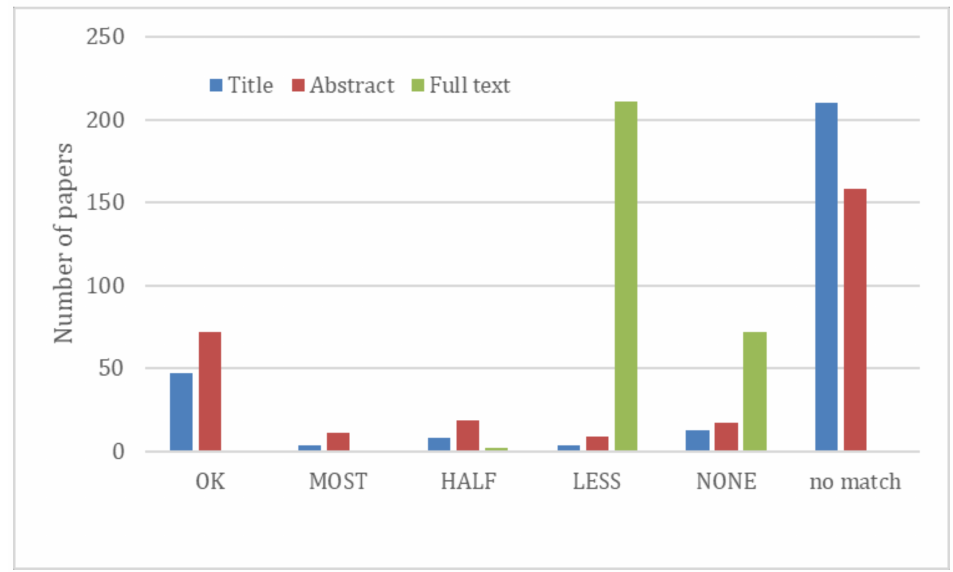
Figure 1. Distribution of papers according to whether the automatically georeferenced names were all correct (OK), mostly correct (MOST), half correct (HALF), less than half correct (LESS), all incorrect (NONE), and if there were no place names found at all (no match), which were searched in either title, abstract, or full text. Although most of the papers had no place names in title or abstract, of those which had, they were mostly